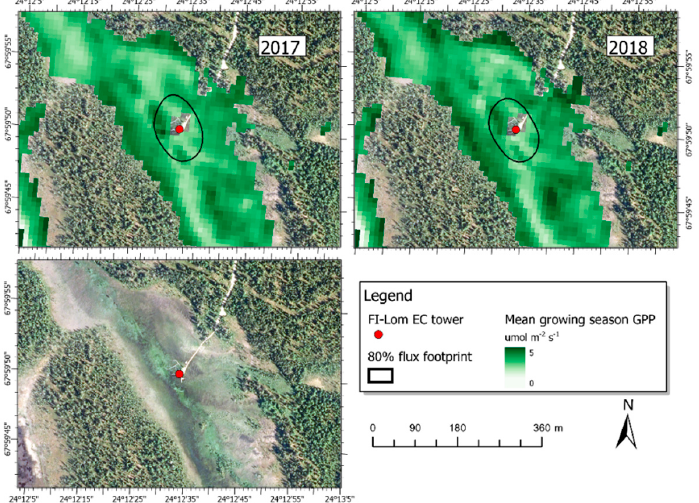
Figure 8. Mean growing season GPP modelled using Equation (4) with LOOCV-parameterization and Sentinel-2 data as input during the growing season in 2017 (top left) and 2018 (top right) at the Lompolojänkkä site. The black lines show 80% of the annual EC flux footprint climatologies. The background image is an aerial photograph recorded in 2018 by the National Land Survey of